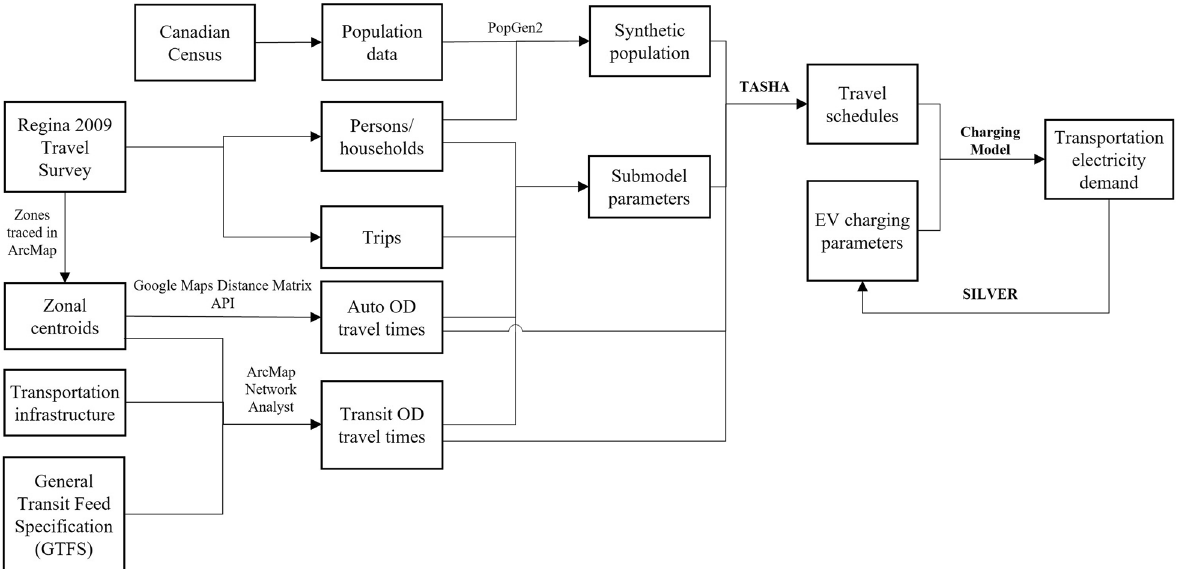
SILVER SILVER, a production cost model with a high spatiotem- poral resolution of power system operations, is used to represent the effect of EV charging on GHG emissions and operating costs. SILVER has been used to model storage asset deployment (McPherson and Tahseen 2018). A detailed description of SILVER’s